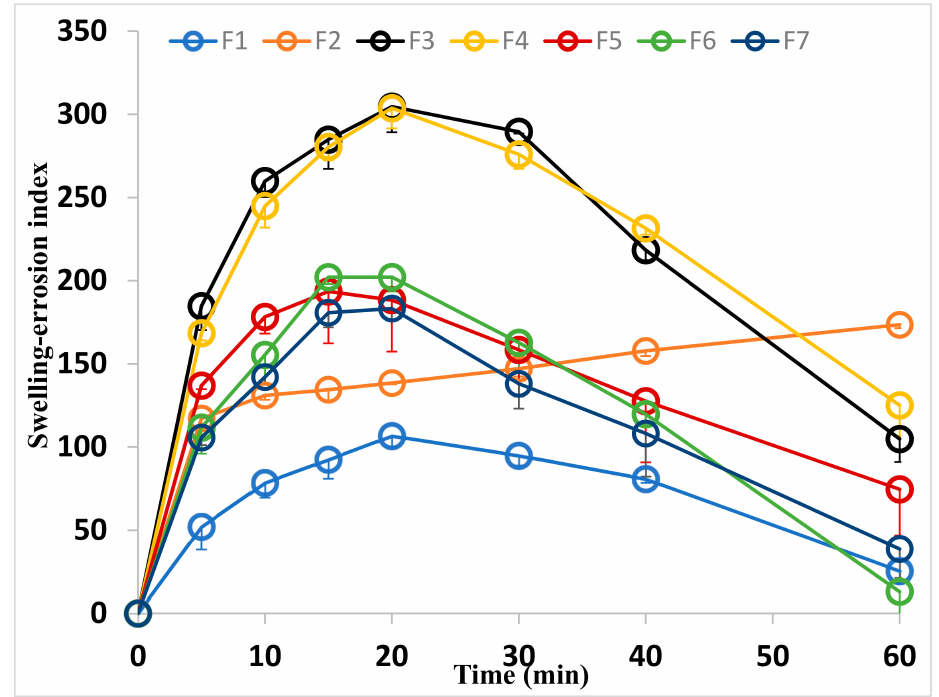
Figure 4. Swelling index of the placebo and medicated bioadhesive films papered by using different drug concentrations.